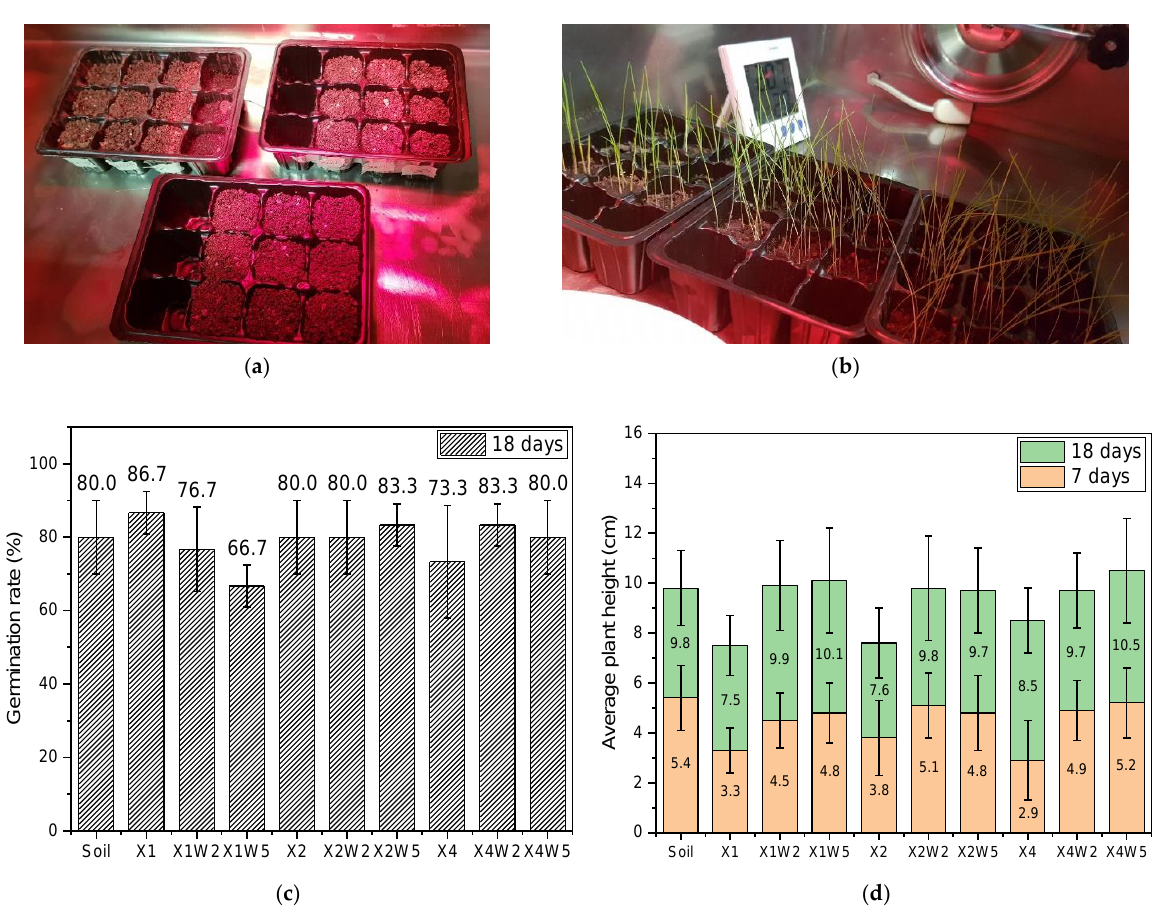
Figure 9. Representative images of ( a ) the grass seeds planted in the different biopolymer-soil culture media and of ( b ) the grass growth after 18 days. ( c ) Germination rate after 18 days and ( d ) average plant height over time.